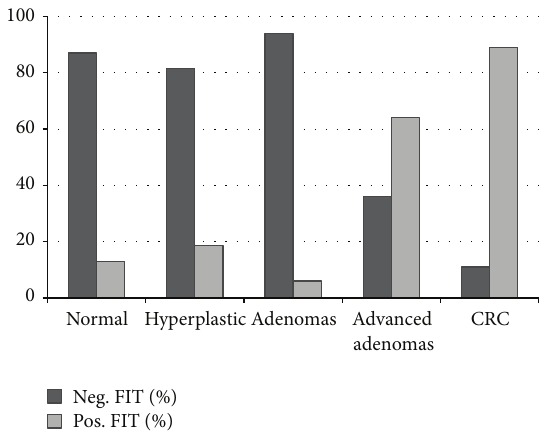
Figure 1: Flow chart of entry into the study. Table 2: Main indications for colonoscopy in the study population.